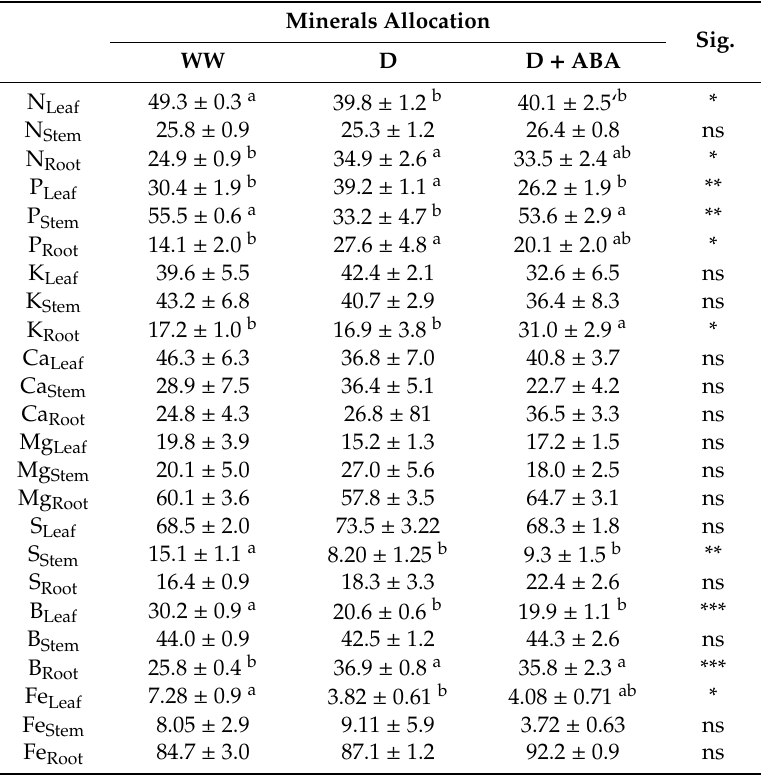
Table 4. Minerals allocation (%) by the di ff erent plant organs of well-watered (WW) and droughted without (D) and with abscisic acid (D + ABA) plants at the end of the